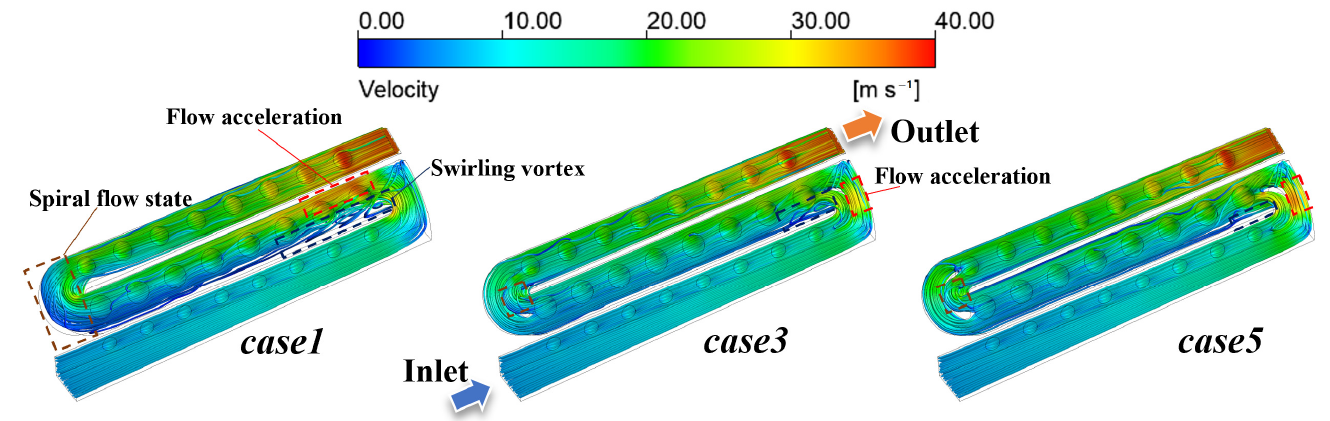
Figure 4. Streamlines of channels, Re = 10,000.